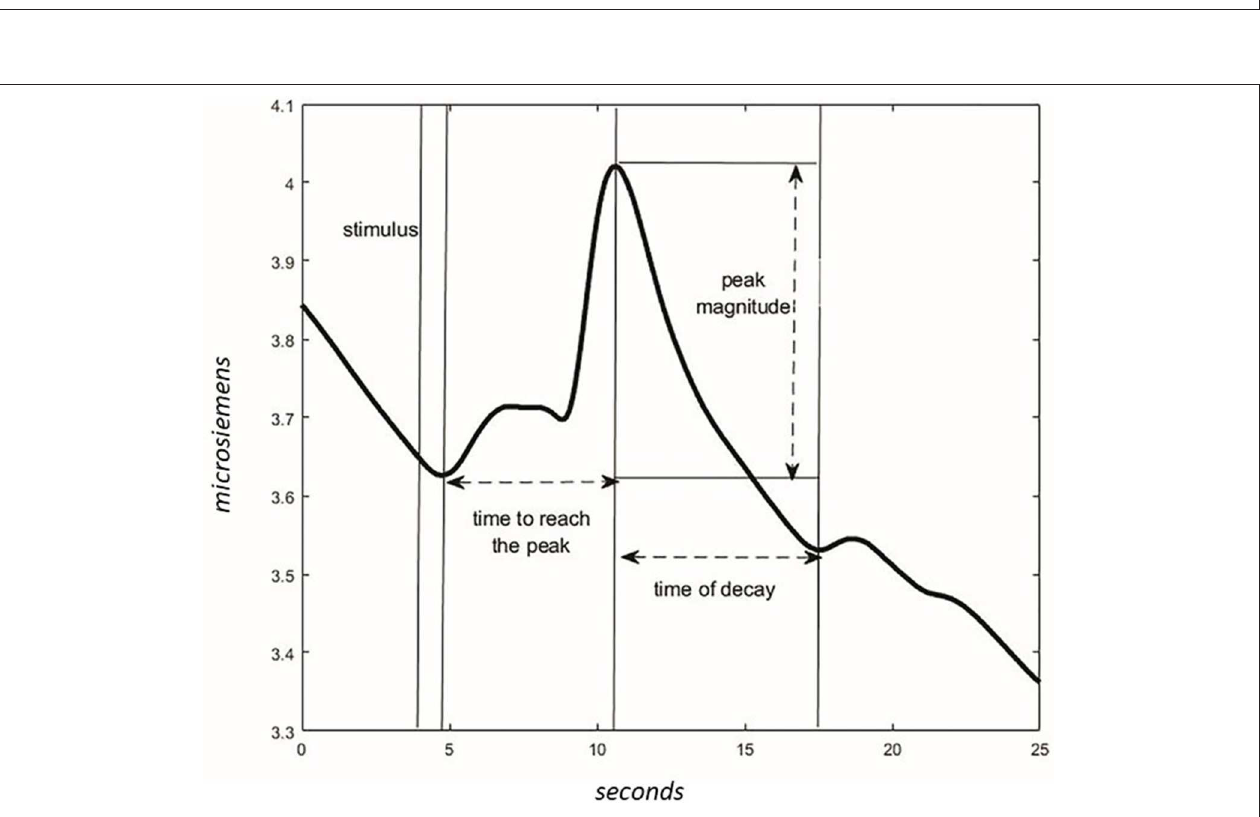
FIGURE 4 | Characteristics of the wave in the GSR signal. After the stimulus, the time to reach the peak of max magnitude is calculated. The magnitude is different between values of peak and values at the start of the stimulus. The time of the wave’s decay is the phase of decreasing after reaching the peak.